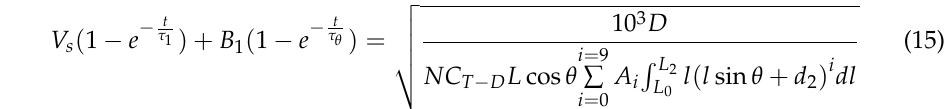
Figure 16. Stress analysis result of the microgripper with the applied voltage of 400 V.